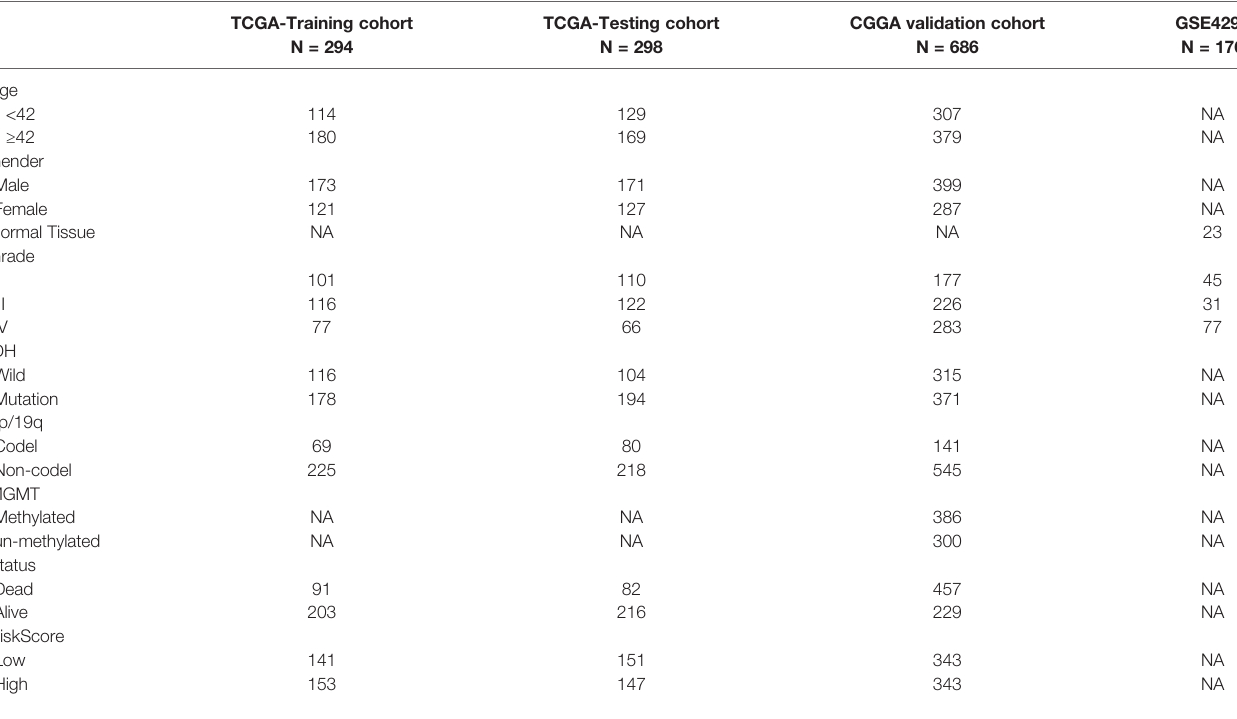
TABLE 1 | Clinicopathological characteristics of glioma patients from the TCGA, CGGA and GEO